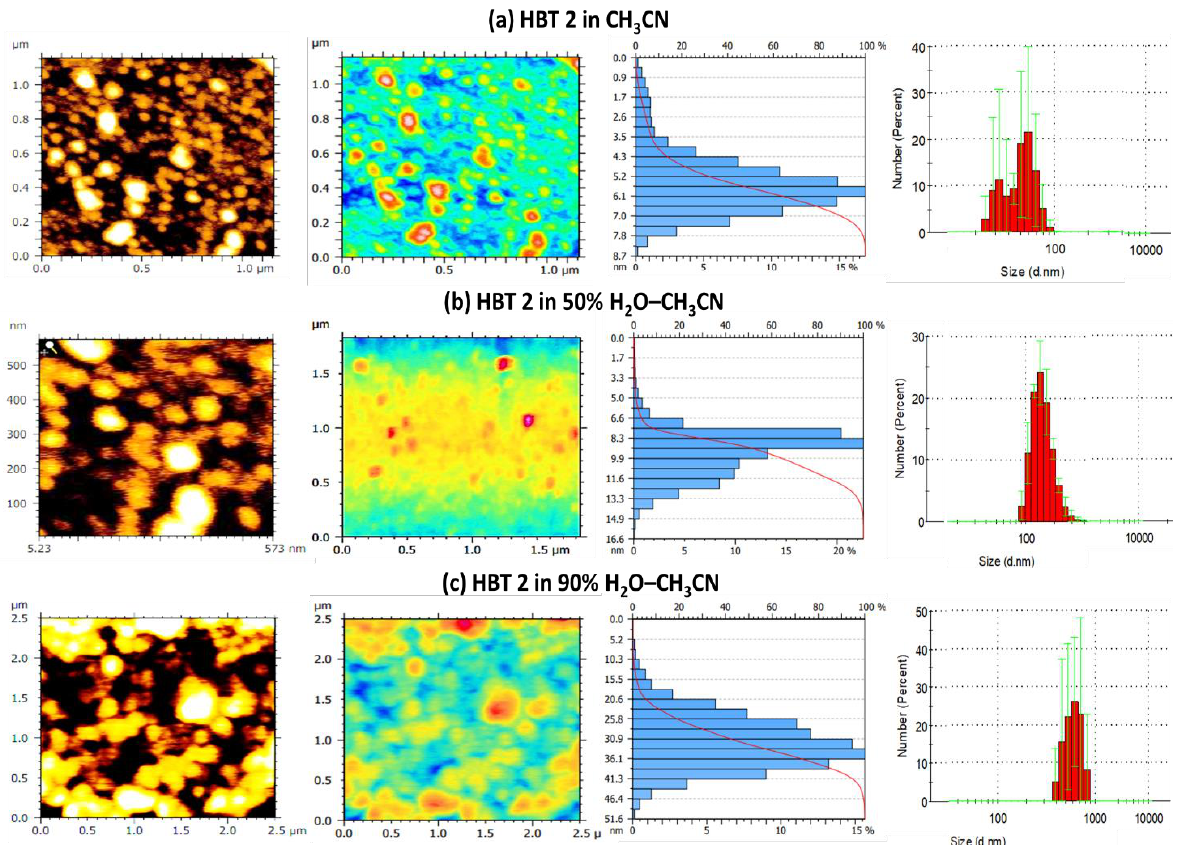
Figure 4. AFM micrographs, electron density profile, histogram showing size of aggregates 2 (1 µ M) and DLS bar graph of HBT 2 (0.5 µ M) in ( a ) CH 3 CN; ( b ) 50% HEPES buffer:CH 3 CN and of HBT 2 (1 µM) and DLS bar graph of HBT 2 (0.5 µM) in ( a ) CH 3 CN; ( b ) 50% HEPES ( c ) 90% HEPES buffer:CH 3 CN buffer:CH 3 CN and ( c ) 90% HEPES buffer:CH 3 CN solution.